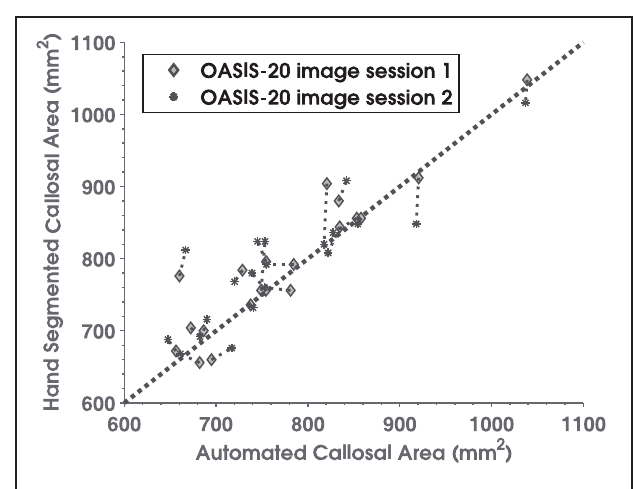
FIGURE 5 | Scatterplot comparing manually delineated corpus callosum total cross-sectional areas (y-axis) with C8 area estimates (x-axis) for 20 normal subjects in the OASIS database who underwent repeated scans. Diamonds are from image session 1 and asterisks are for session 2. Thin dotted lines connect results for the same subject’s two sessions, while the thick dotted line is the area diagonal.